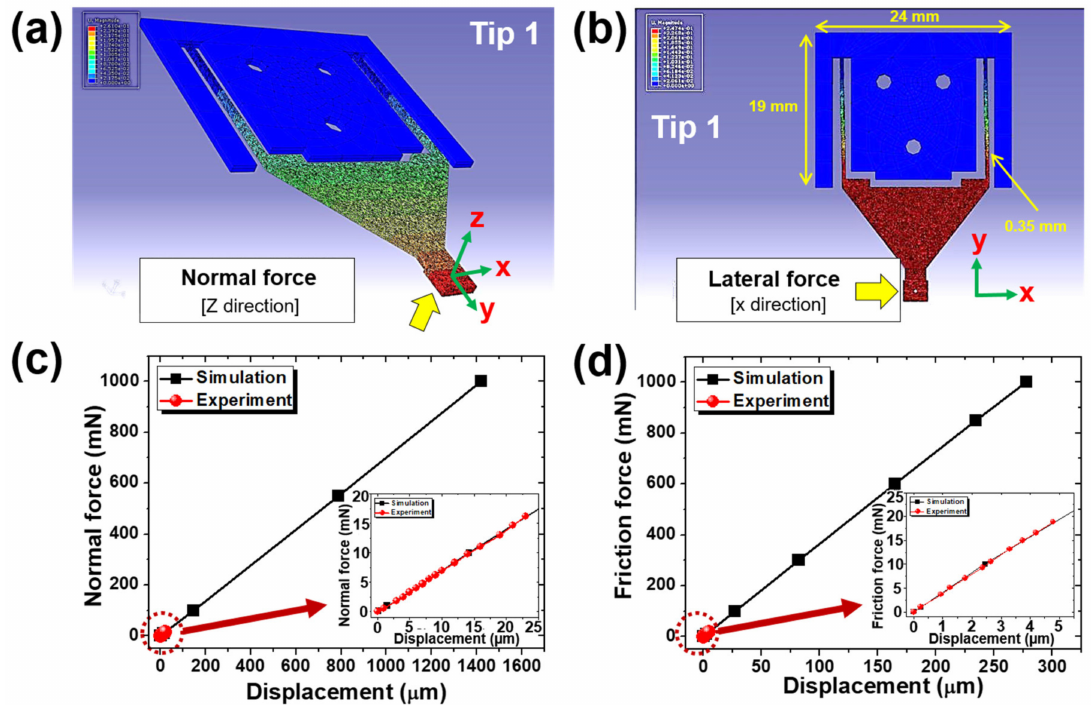
Figure 3. Calibration of the cantilever tip using finite element analysis (FEA) simulations: ( a , b ) results of FEA simulation showing the displacement of a cantilever tip in ( a ) vertical and ( b ) lateral directions by a force of 1 N; ( c , d ) comparison of relationship between ( c ) normal / ( d ) friction forces and displacements in vertical / lateral directions by experiment and FEA